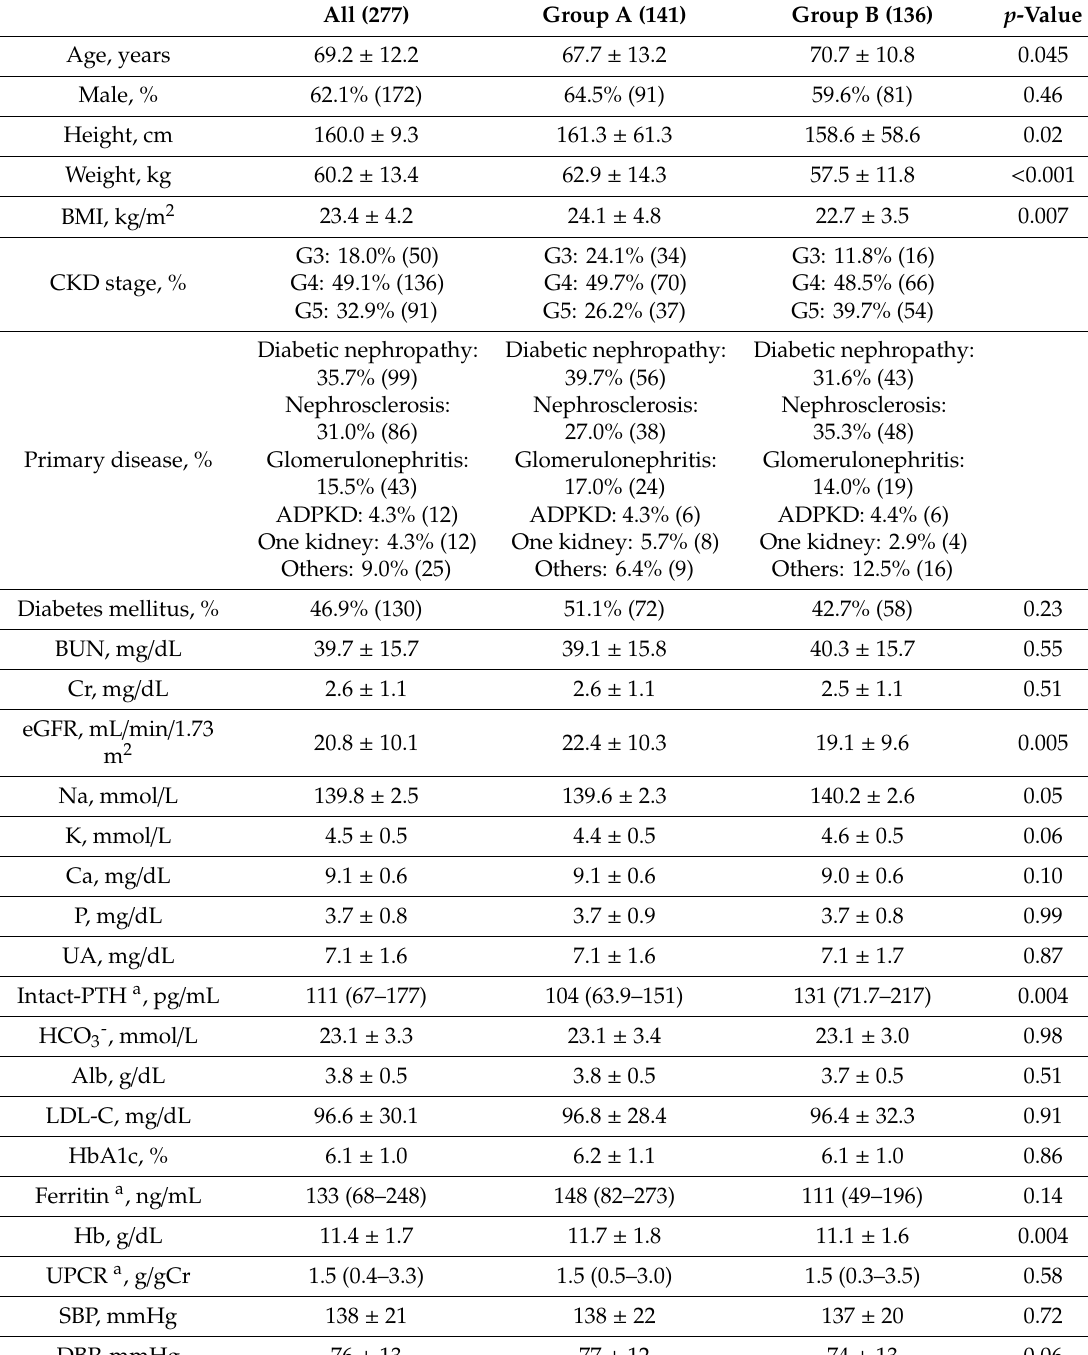
Table 1. Characteristics of patients in the two